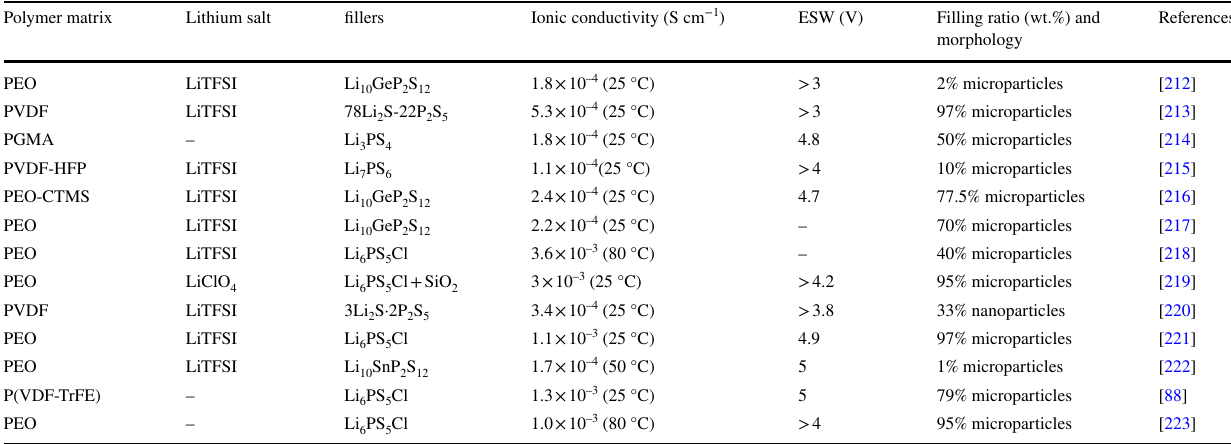
Table 6 PIEs filled with sulfide-type fillers and their properties Polymer